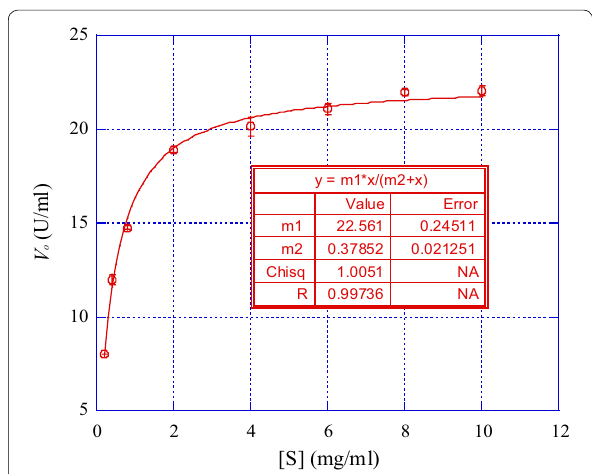
Fig. 9 Michaelis–Menten type kinetics of the purified AMG enzyme versus soluble starch concentration. All error bars are represented as the standard errors of the means (SEM) (m 1